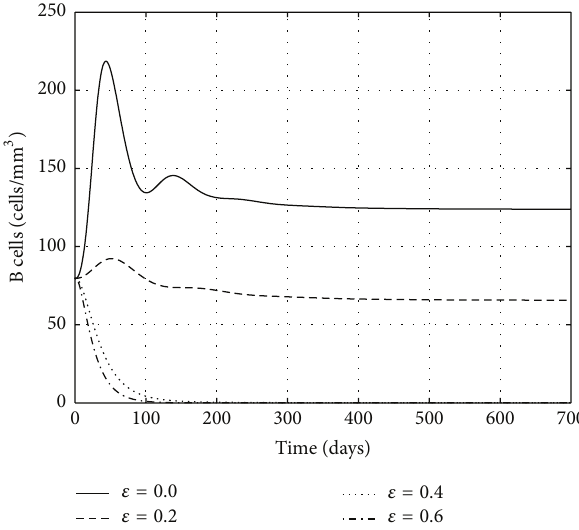
Figure 11: The concentration of uninfected CD4 + T cells for model (104).